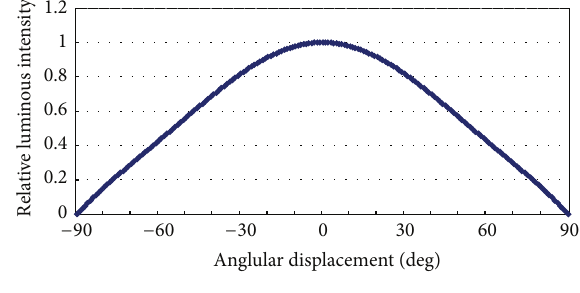
Figure 15: Radiation patterns.